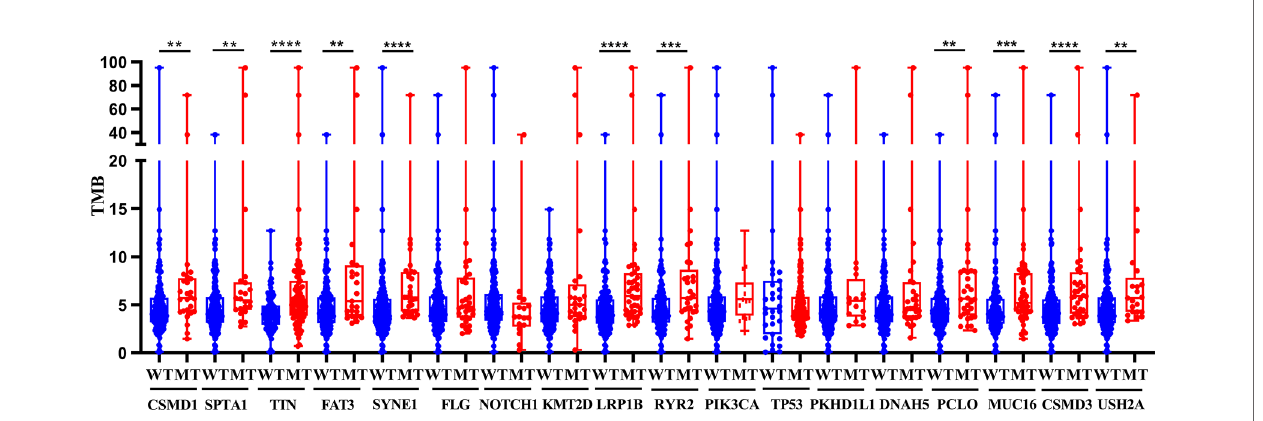
FIGURE 2 | Gene mutations are associated with TMB. Compared with the wild type of genes, the mutation type of CSMD1, SPTA1, TTH, FAT3, SYNE1, LRP1B, RYR2, PCLO, MUC16, CSMD3, and USH2A had signi fi cantly higher TMB in patients with ESCA. **p < 0.01; ***p < 0.001; ****p<0.0001. WT, wild type; MT, mutant